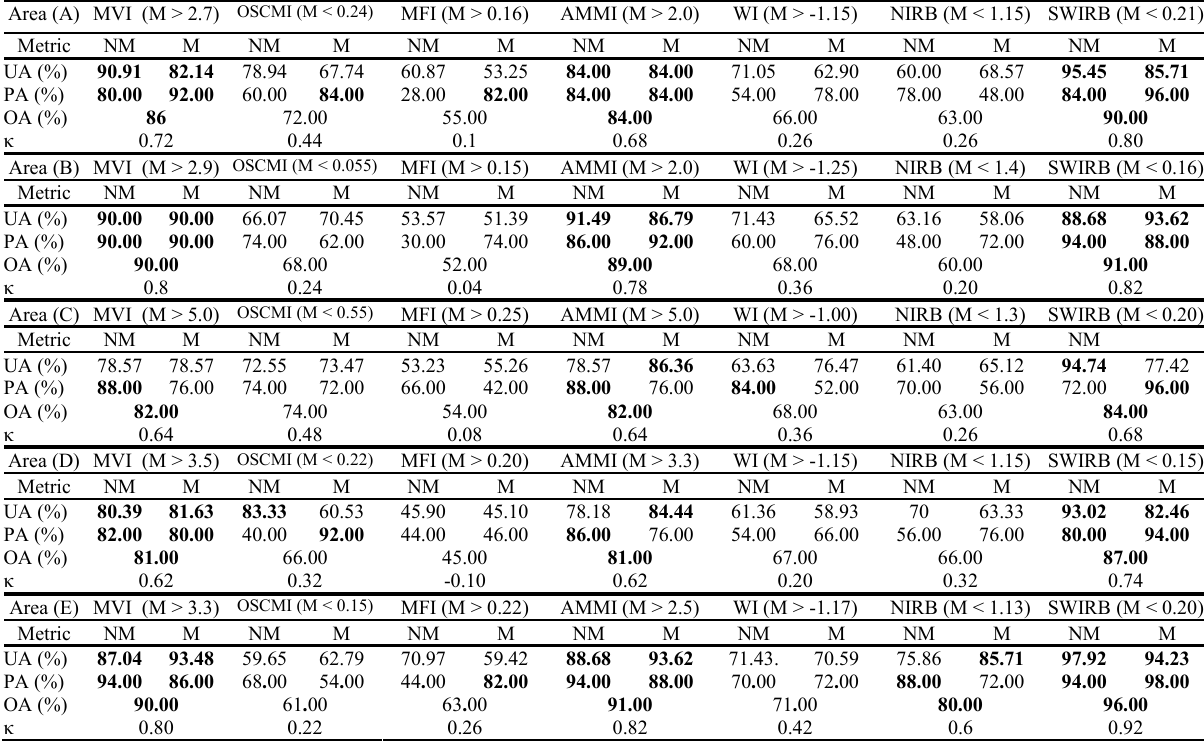
Table 4. Accuracy assessment of mangrove extraction results using the indices with their respective mangrove extracting threshold. (A) Puerto Princesa City, Palawan, Philippines; (B) Busuanga, Palawan, Philippines; (C) Siargao Island, Surigao del Norte, Philippines; (D) Select municipalities of Tawi-Tawi, Philippines; (E) Karimunjawa-Kemujan Islands, Indonesia.